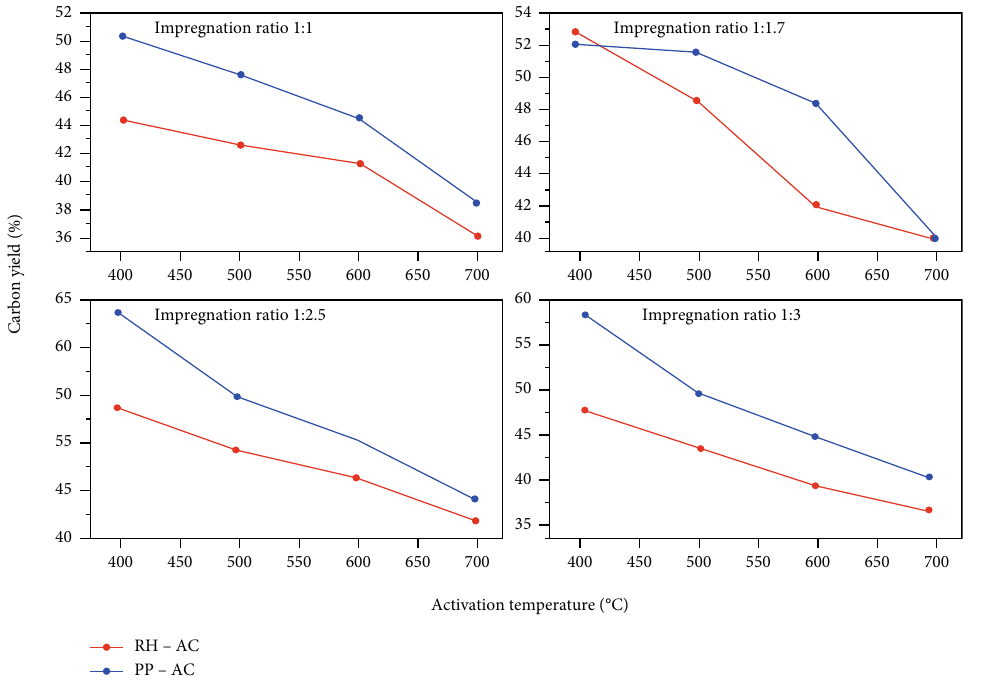
Figure 1: The e ff ect of the impregnation ratio and carbonization temperature on carbon yield. Table 1: The e ff ect of the impregnation ratio and activation temperature on moisture content. Activation temperature ( °